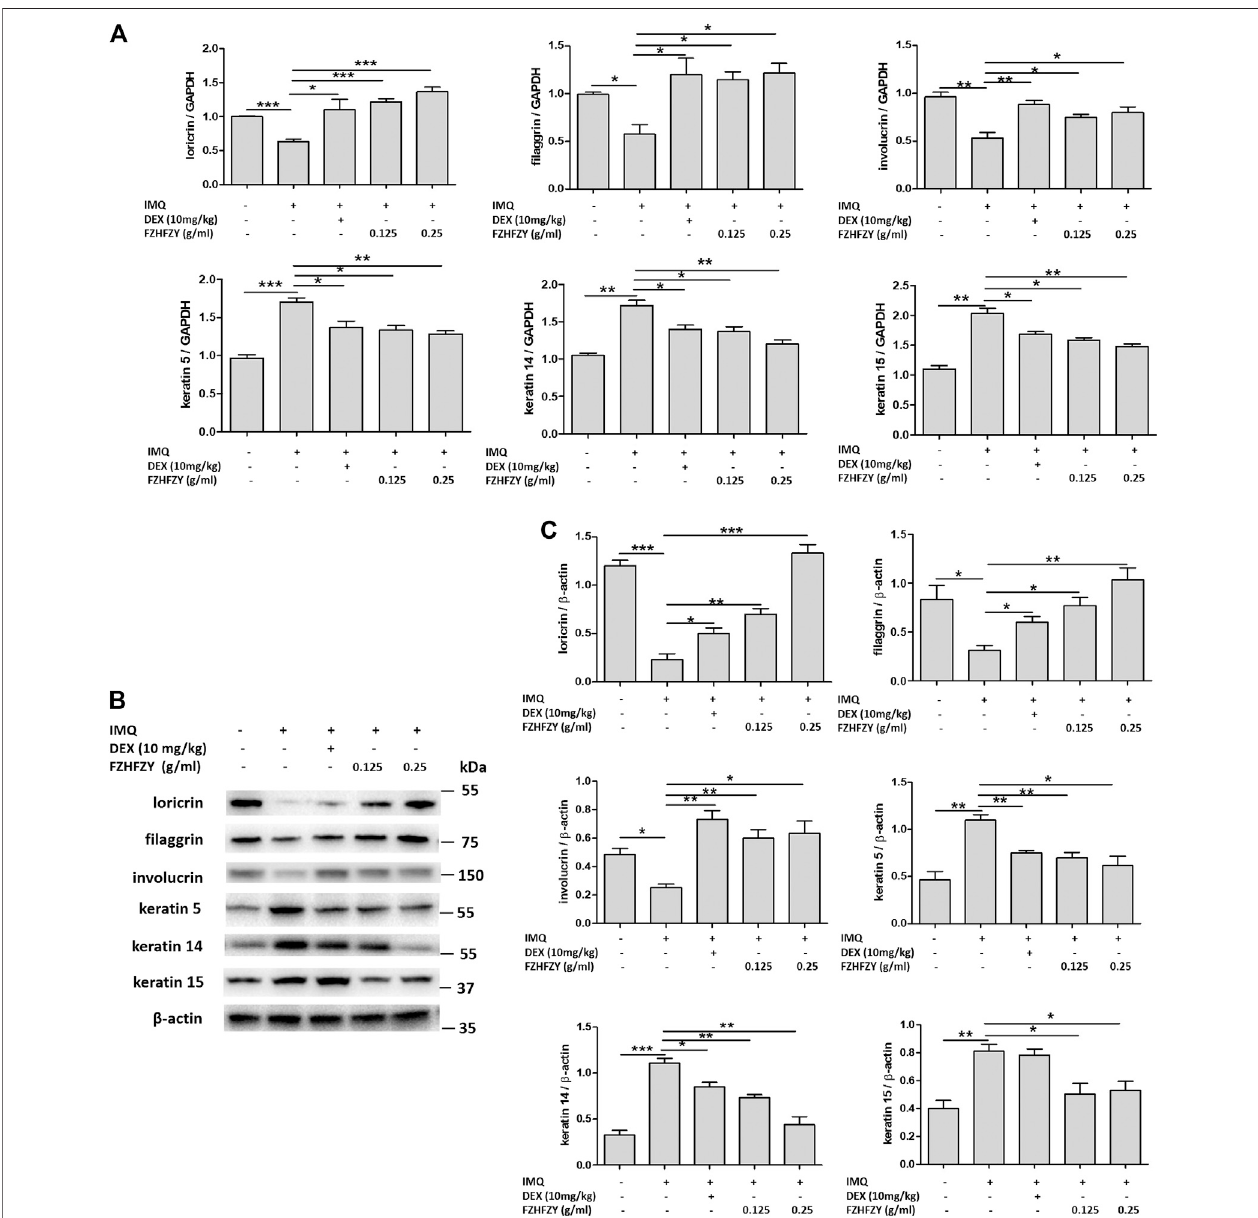
FIGURE 4 | FZHFZY regulates the mRNA and protein expression of epidermal differentiation molecules in IMQ-induced psoriatic mice. (A) Total RNA was isolated from skin tissues, and RT-PCR was used to investigate the levels of loricrin, fi laggrin, involucrin, keratin 5, keratin 14 and keratin 15. (B) Representative western blot of epidermal differentiation protein in the skin of mice with IMQ-induced psoriasis. (C) Quanti fi cation of the amounts of epidermal differentiation protein to β -actin. Data are shown as the mean ± standard error of at least three independent experiments (* p < 0.05, ** p < 0.01, *** p < 0.001 vs . IMQ-induced psoriasis group; n (cid:2) 6).